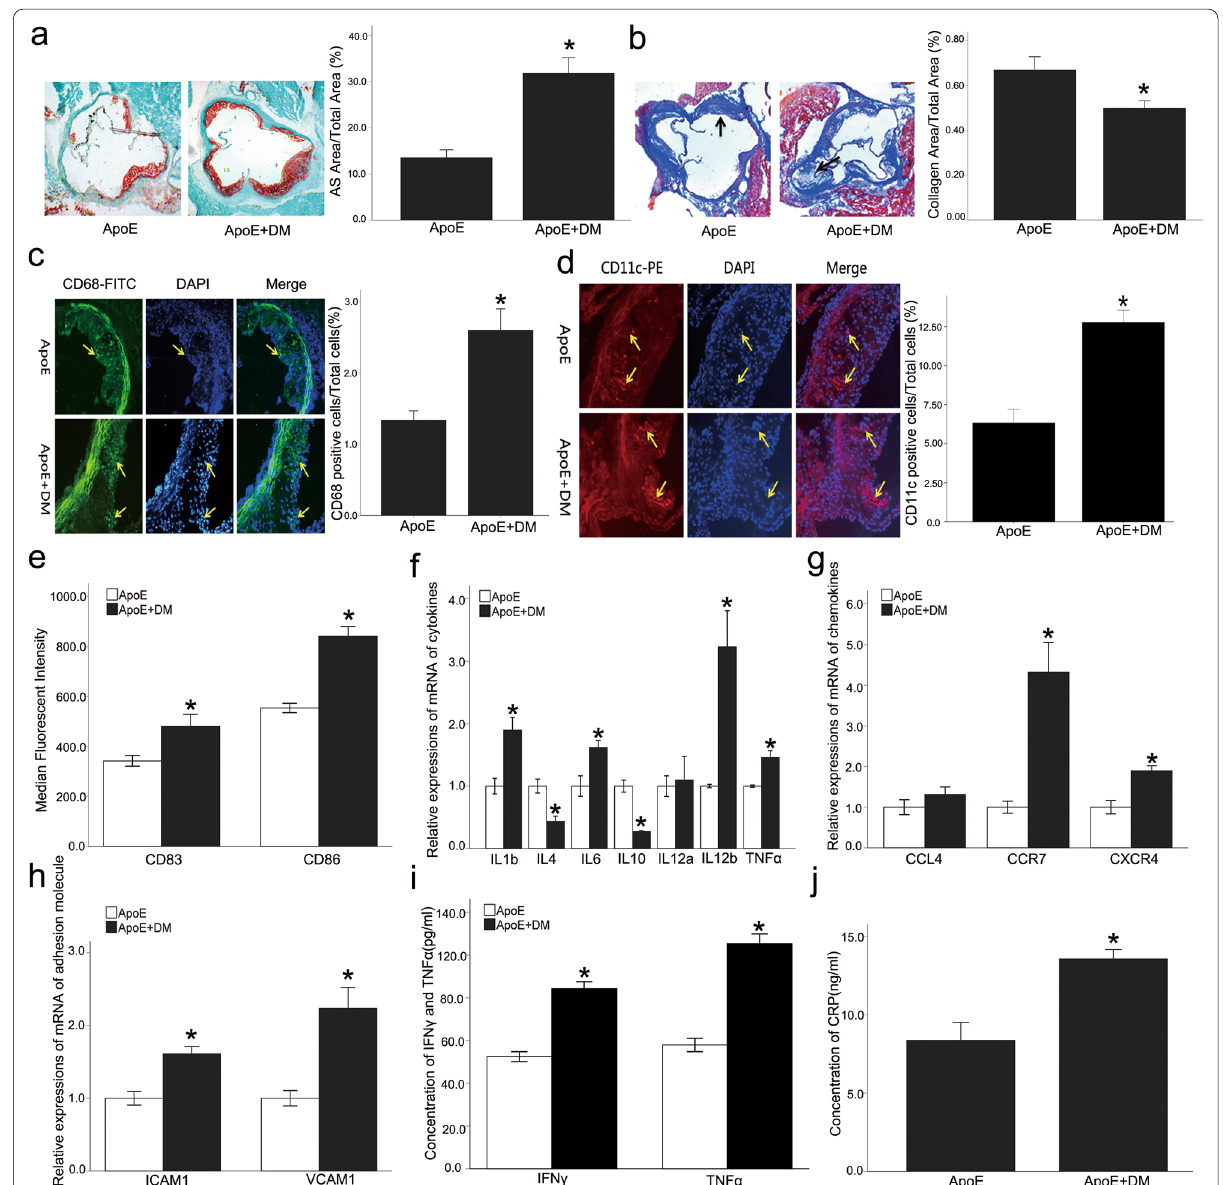
Fig. 1 Diabetic ApoE − / − mice increased aortic atherosclerosis with chronic low-grade inflammation and dendritic cell activation. Compared with the control group, the size of the atherosclerotic plaques ( a ) in the aortic roots of the diabetic ApoE − / − mice was increased, and the plaque collagen content ( b ) was decreased, while the numbers of macrophages c and DCs d were increased. The expression of CD83 and CD86 e in DCs isolated from spleens was increased, as well as the expression of IL12b, IL4, IL6 ( f ), and chemokine receptors such as CCR7 and CXCR4 g also were up-regulated in the diabetic mice. The expression of ICAM and VCAM ( h ) in the aorta were up-regulated in the diabetic ApoE − / − mice, and the concentrations of TNFα, IFNγ, and CRP ( i , j ) were also significantly increased in peripheral blood. Values, mean scale bar, 250 μm; DM Diabetes mellitus, AS Atherosclerosis, DAPI 4,6-diamino-2-phenyl indole, IL Interleukin, ICAM Intercellular adhesion molecule, VCAM Vascular cell adhesion molecule, TNFα Tumor necrosis factor alpha, IFNγ IFN gamma. CRP C-reactive